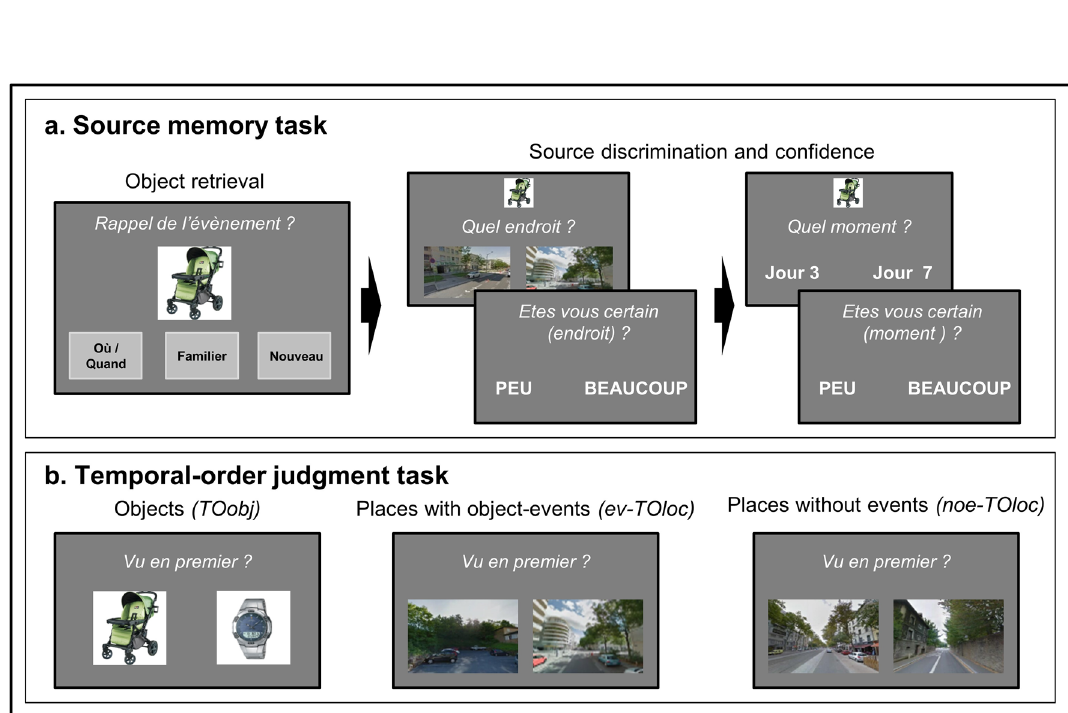
Figure 2. Retrieval tasks. ( a ) Illustration of the phases of the explicit source retrieval task. The task began with the presentation of the object-probe and the participant reported whether they had seen the object during the encoding phase and whether they could remember the place/time of that event. We label the three possible responses as Remember , Familiar or New . If the object was seen at encoding and correctly recognized as old (i.e. Rem or Fam response) , the trial continued with a sequence of questions concerning the time/place-context. The place-test comprised a 2-alternative forced-choice discrimination task involving the presentation of an image associated with the place where the object was presented during encoding, plus a foil place-image. For the VR and SL protocols the place-images corresponded to the participant’s view at encoding, while for the RW protocol the images were obtained from Google-images based on GPS coordinates and phone orientation. A confidence question followed the place-image discrimination ("how sure are you? very much/little"). The time-test also entailed a 2-alternative forced-choice, now comprising two time windows. One of the two windows included the moment when the object was presented. A confidence question followed the time-discrimination. The presentation order of the place and time source-tests was randomized across trials. ( b ) Example trials of the temporal-order judgment task. All trials included the presentation of two images side-by-side and the task of the participant was to report what image referred to the event that happened earlier during the encoding. In two separate blocks, the images comprised either the memorized object ( TOobj ), or images of places ( TOloc ). The place-images were either associated with an object-event during encoding ( ev-TOloc ) or referred to seen/visited places but where no object-event took place ( noe-TOloc ). The ev-TOloc and noe-TOloc trials were randomized within the TOloc block. The task’s instructions were displayed in